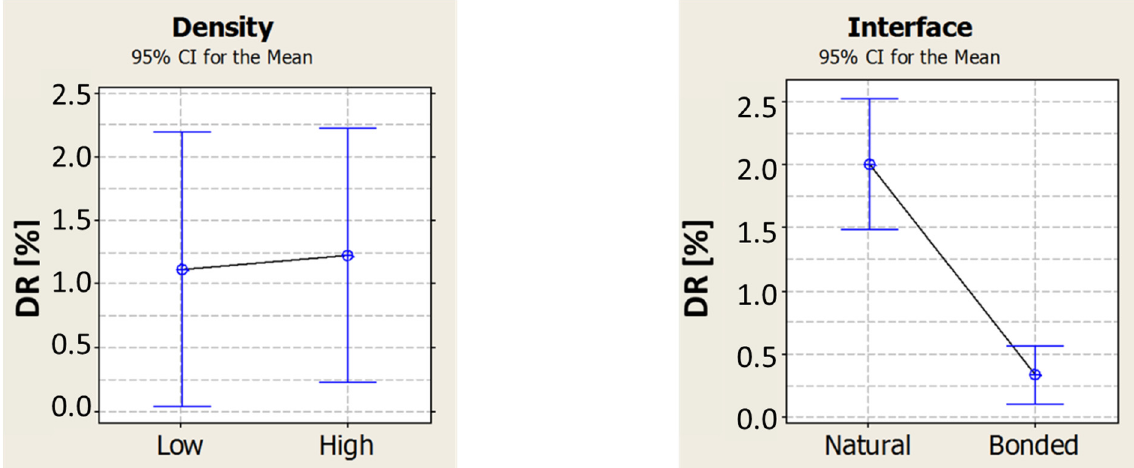
Figure 10. Effect of foam density and interface condition on damping ratio in the high-frequency range (2nd mode of